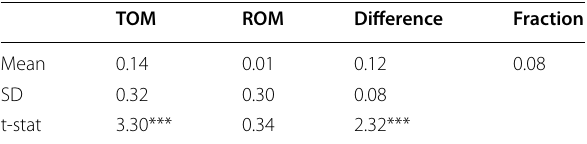
Table 2 T-test of means for “turn-of-the-month-effect” on overall